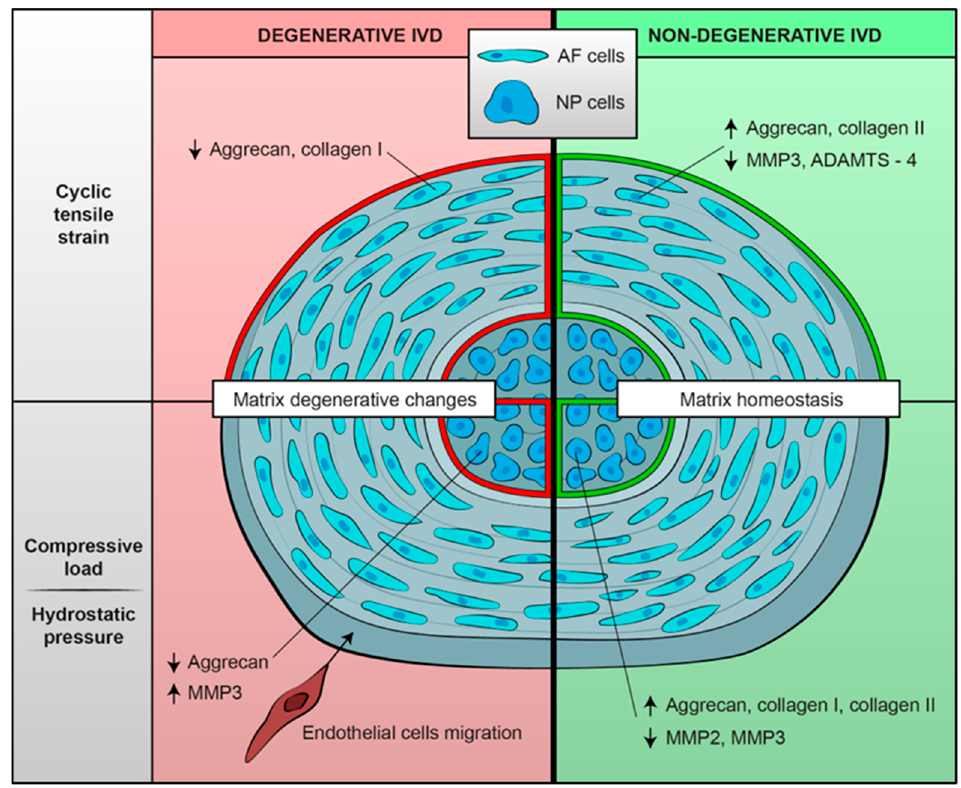
Figure 2. Summary of biological mechanoresponses of human intervertebral cells, either degenerative or non-degenerative, to different mechanical stimuli in terms of extracellular matrix changes. Mechanical load seems to determine a shift towards an anabolic phenotype in non-degenerated IVD cells; on the contrary, degenerated IVD cells exposed to mechanical stimulation show matrix catabolic changes.